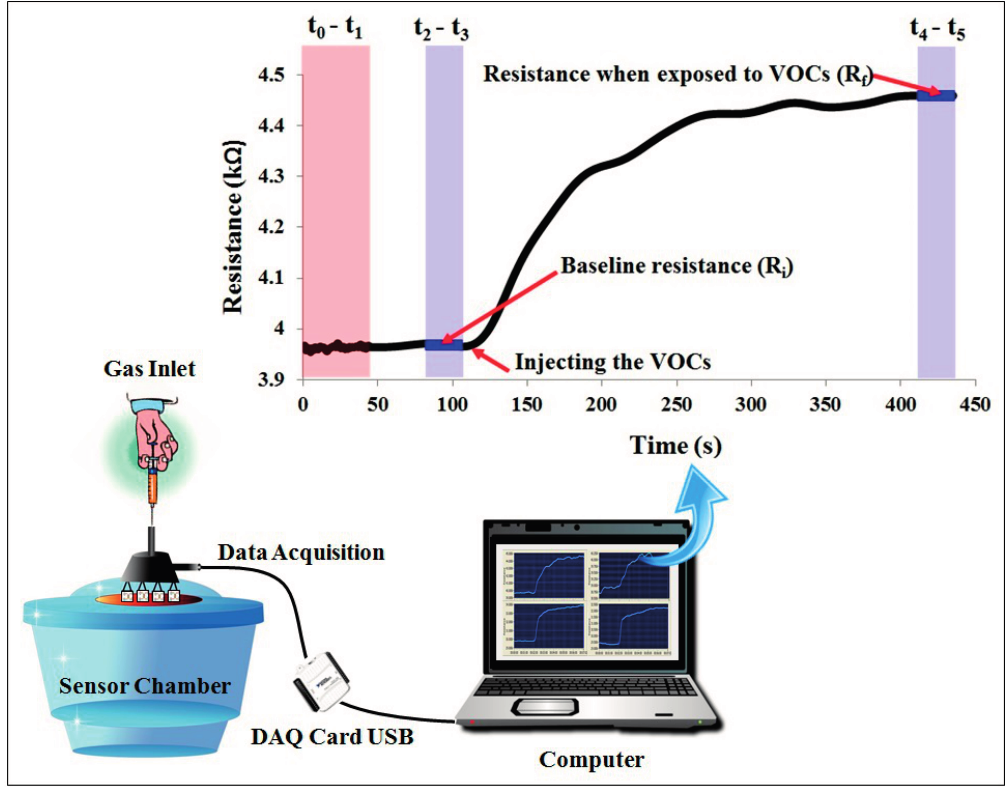
Figure 4. Static measurement system for detecting volatile organic